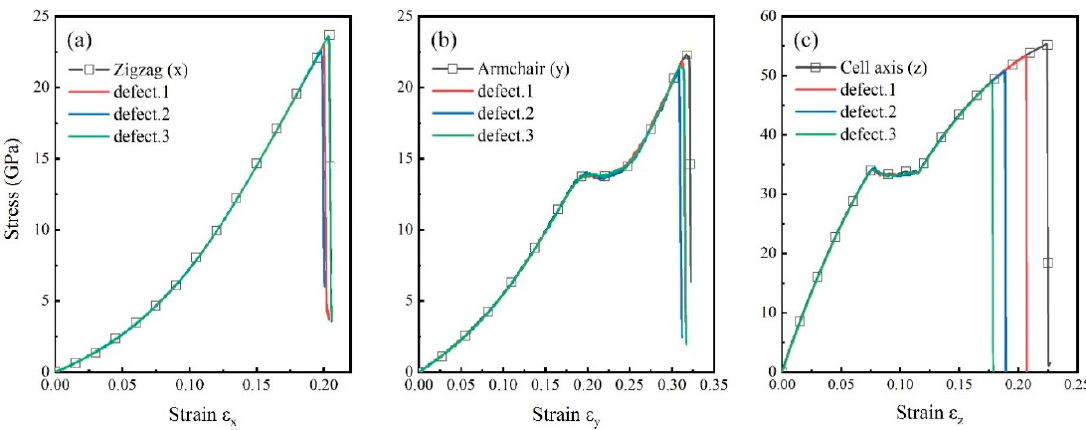
Figure 4. Effect of vacancy defect. Engineering stress-strain curves of carbon honeycomb for loading along ( a ) zigzag, ( b ) armchair and ( c ) cell axis directions, respectively.